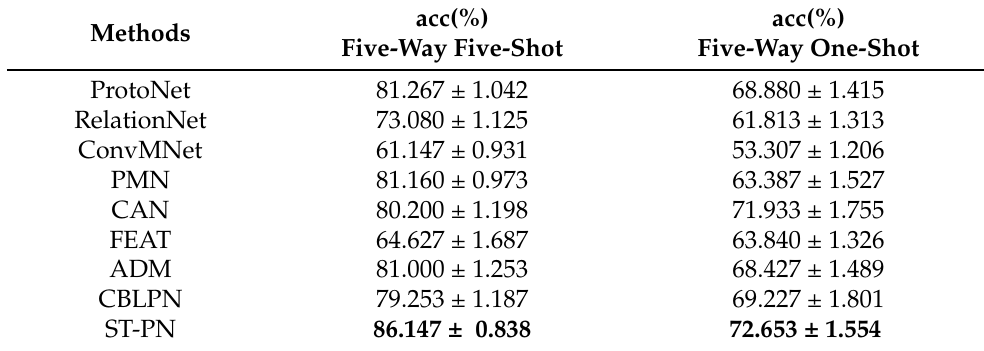
Table 3. Experimental results of some typical FSL